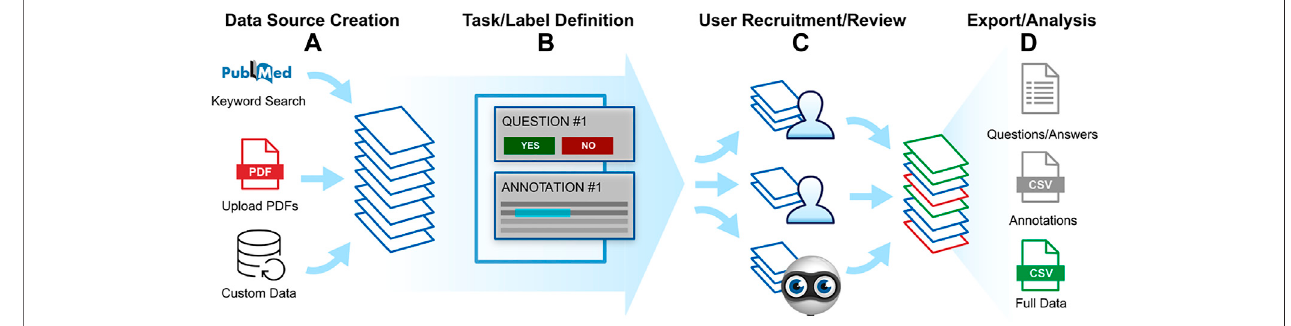
FIGURE 1 | Sysrev projects can be broken into 4 stages from left to right. (A) Articles are collected to form a data source. (B) Review tasks or “ labels ” are de fi ned. (C) Reviewersarerecruitedandaskedtocompletereviewtasks.Activelearningisinvolvedatthisstagetoprioritizeandreplicatelabellingtasks. (D) Dataisexportedand